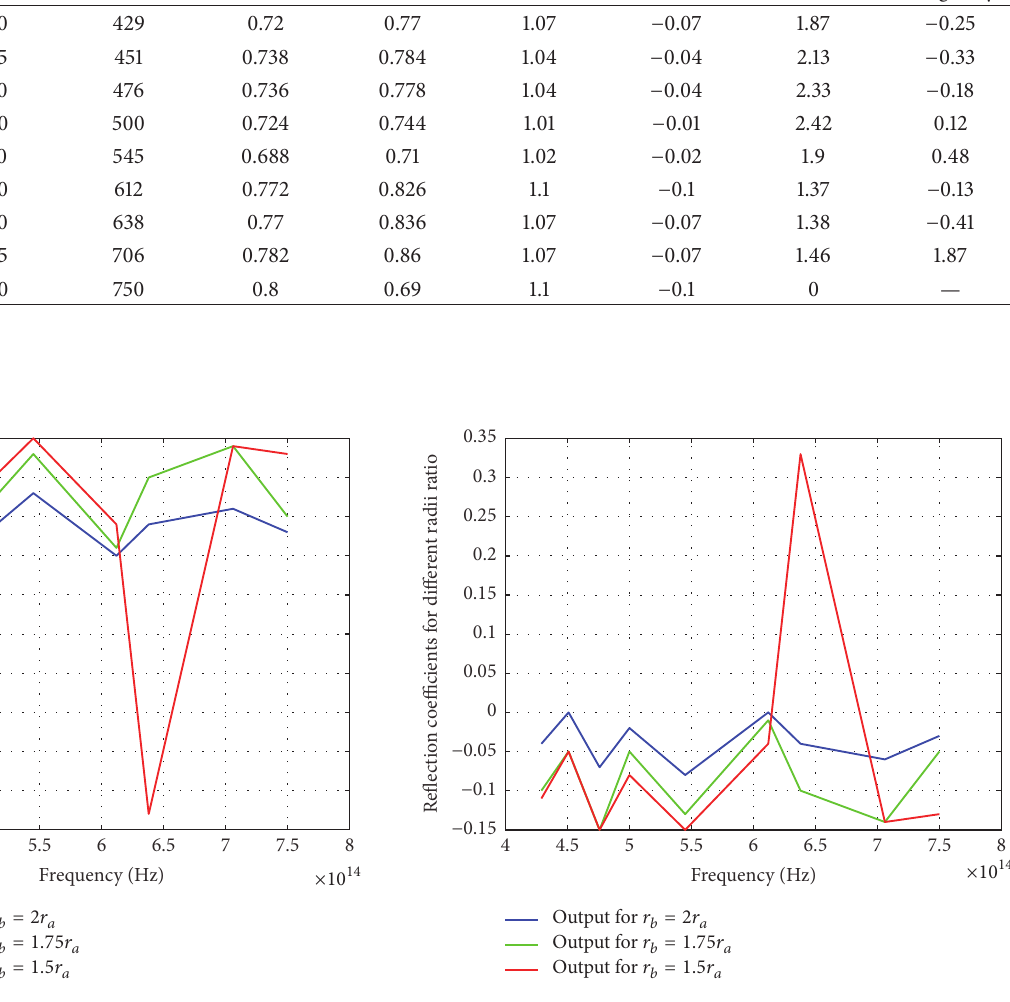
Figure 8: Plots for reflection coefficient versus frequency for different radii